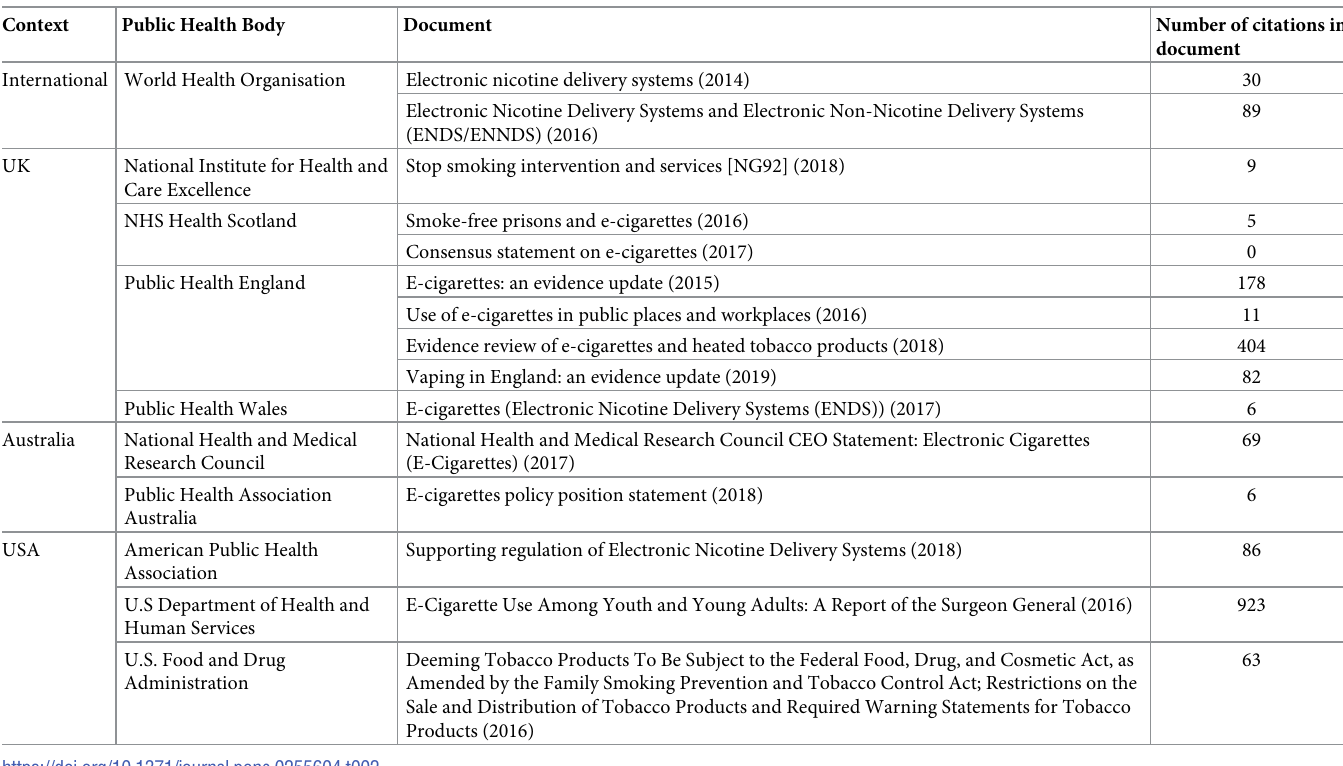
Table 2. Number of citations within each of the 15 selected public health recommendation documents.